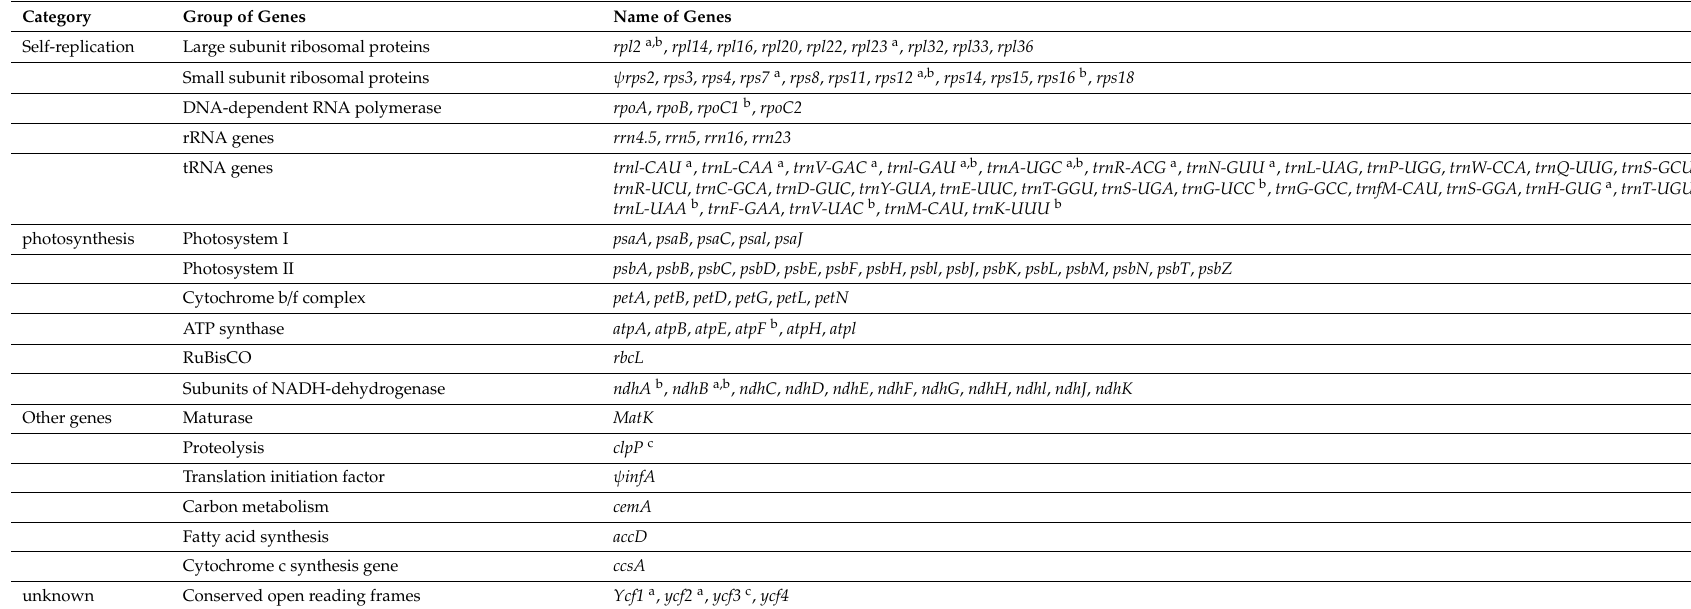
Table 2. Genes present in C. comosum and C. gallabatense chloroplast